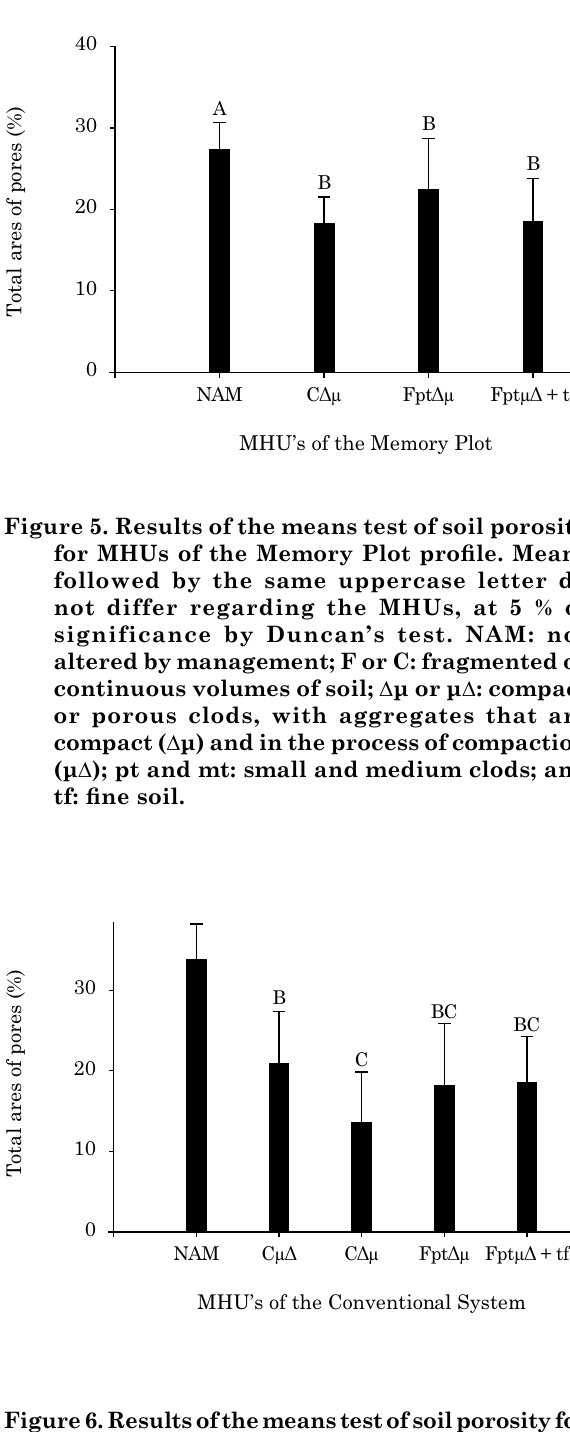
Figure 6. Results of the means test of soil porosity for MHUs of the crop profile under Conventional System (CS). Means followed by the same uppercase letter do not differ regarding the MHUs, at 5 % significance by Duncan’s test.